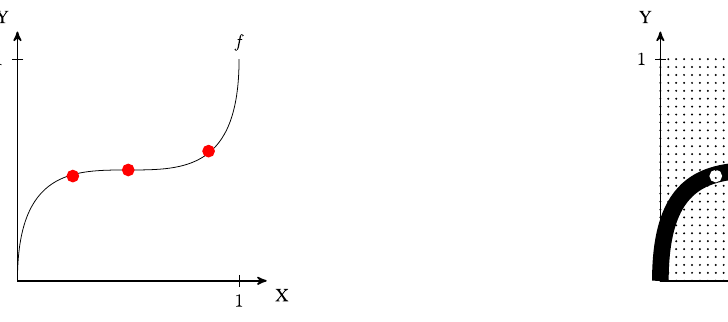
Figure 4: Left: IGCI for a bijective function f : 0, 1 0, 1 [ ] [ ] → . Under certain genericity assumptions, x - values tend to lie in regions with small slope f x ′ ( ) . Right: Drawing the function f with a fat pen, it induces a relation of possible x y , ( ) pairs on the grid ( obtained by discretizing X and Y )